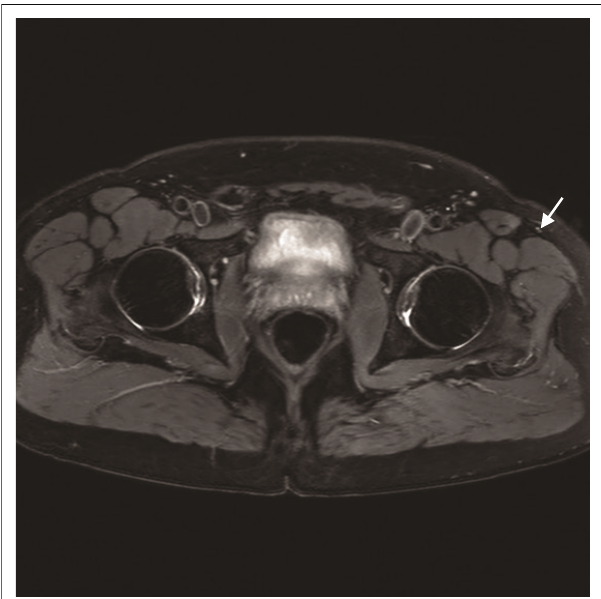
FIGURE 3: 3T proton density fat-saturated axial MR image in the same patient described in Figure 2 demonstrates the persistent high signal of the lateral femoral cutaneous nerve in the subcutaneous tissue where it divides into anterior and lateral